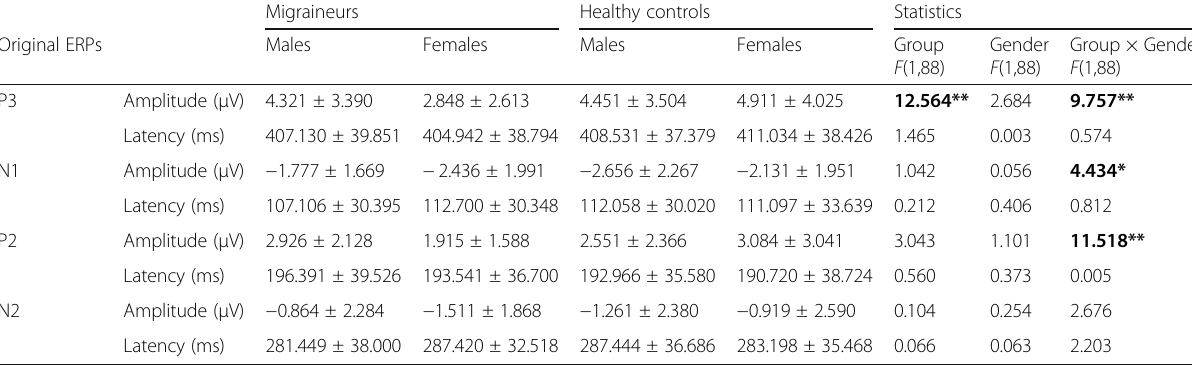
Table 3 Results and analyses of original ERP